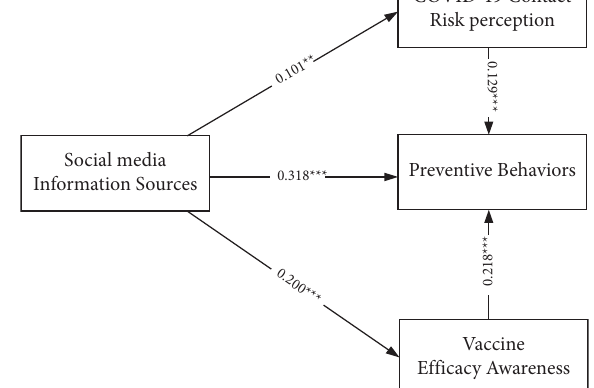
Figure 2: Te multivariate regression models of social